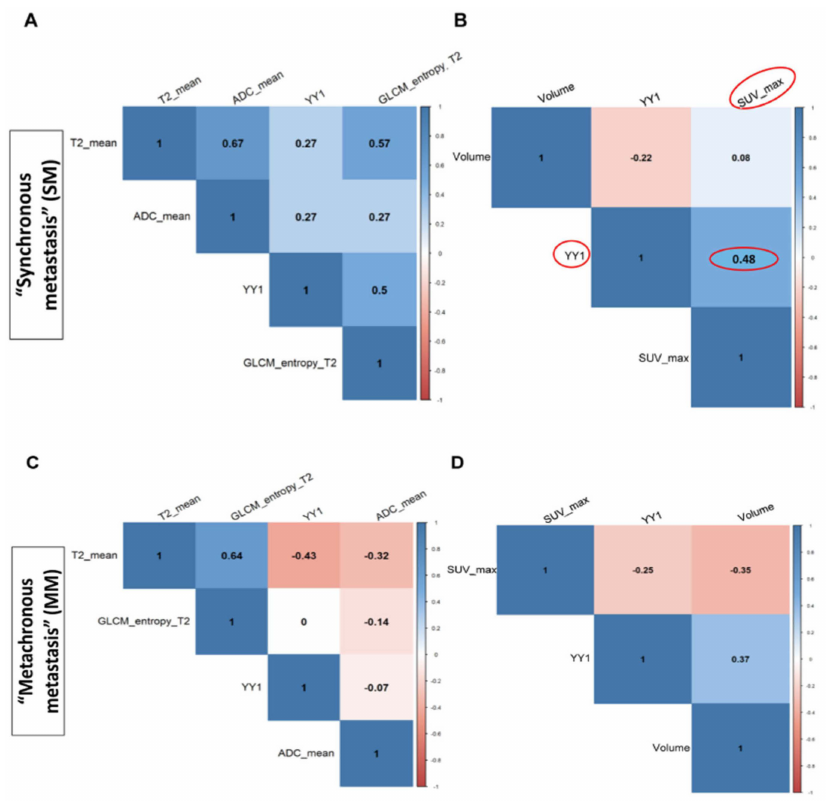
Figure 7. Radiomic features and YY1 molecular analysis. Correlation plot illustrates the Spearman test coe ffi cient between YY1 expression level and PET / RMI parameters across “Synchronous Metatstasis” (SM) ( A , B ) and “Metachronous Metatstasis” (MM) BC patients ( C , D ). Color scale bar shows the positive correlation in blue and the negative correlation in pink; color intensity represents the strength of the correlation coe ffi cient. Data indicated a statistical significant correlation between YY1mRNA and SUVmax in patients with SM ρ = 0.48. In the Supplementary Materials Table S1 are reported all analyzed findings for each patient at primary